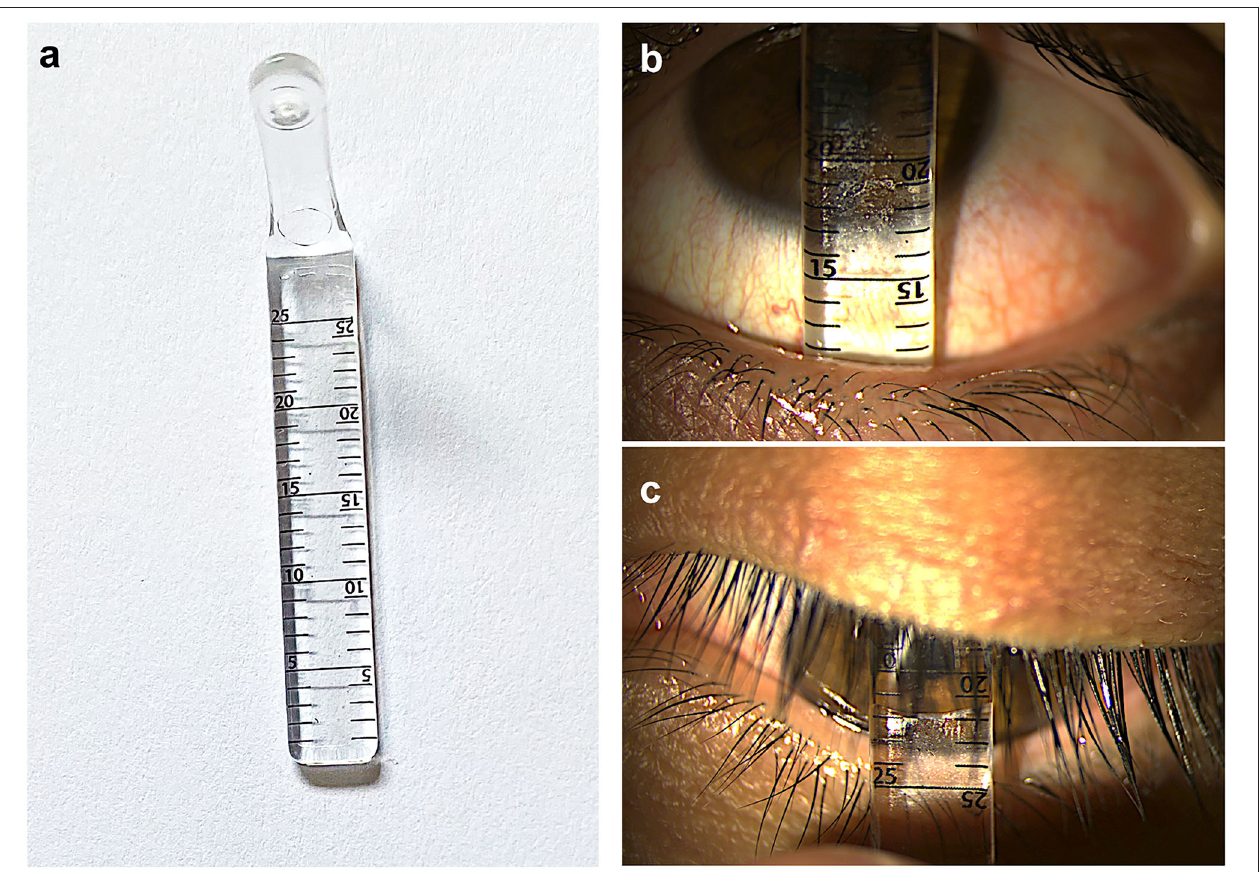
FIGURE 1 | Measuring central conjunctival fornix depths. (a) An example of a fornix depth measurer (Scope Ophthalmics Ltd, United Kingdom). Note the millimetric markings in opposite directions to facilitate measurements in both upper and lower fornices; (b) to measure the central lower fornix depth, eyes are made to look in up gaze and readings taken at the eyelid margin; (c) to measure the central upper fornix depth, eyes are made to look in down gaze.